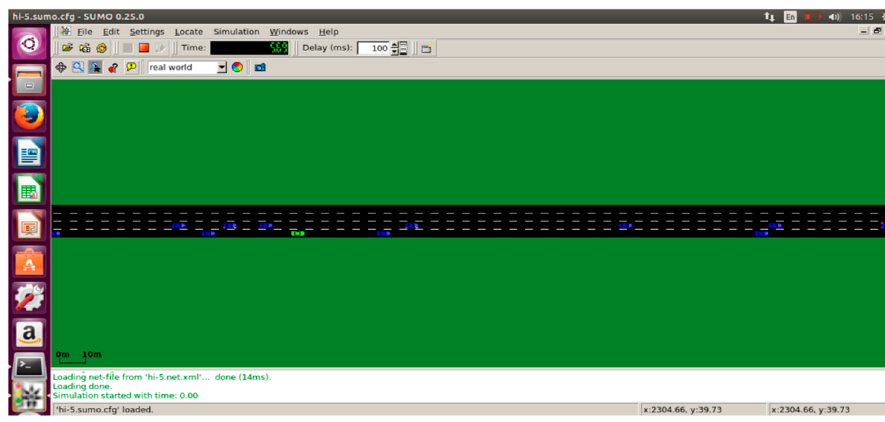
Figure 8. Real time traffic on highway using SUMO.